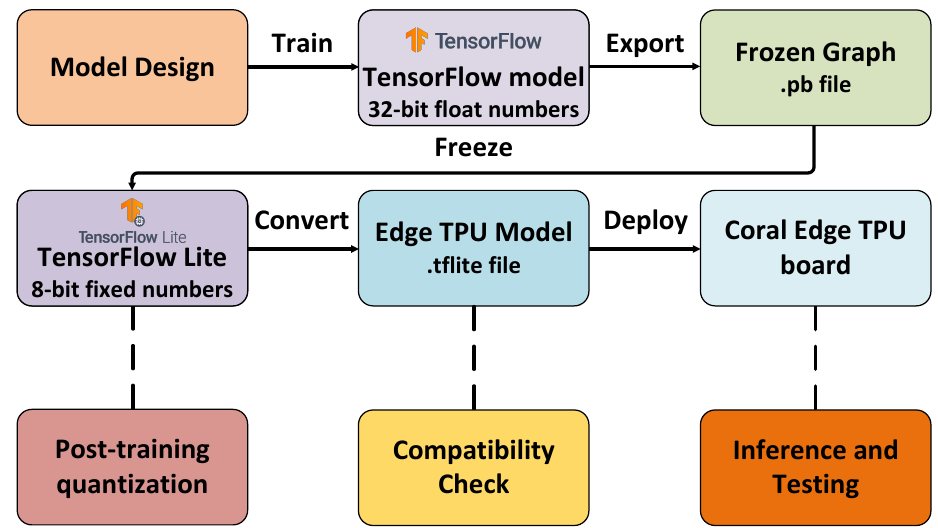
Figure 18. Edge TPU deployment workflow diagram.